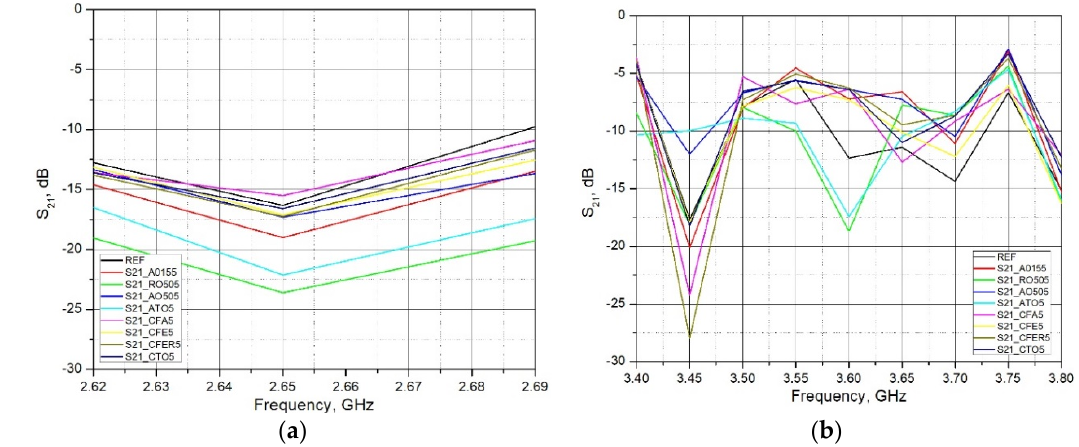
Figure 10 . Measured S 21 parameter of brick samples for ( a ) LTE2600 in a frequency range 2.62 to 2.69 GHz; and ( b ) NR3500 in a frequency range 3.40 to 3.80 GHz, (d = 18 mm; 2r = 150 mm). The ranges shown in Figure 11 are the remaining ranges covered by this measurement, so they need to be analyzed in addition to the previously selected ranges.